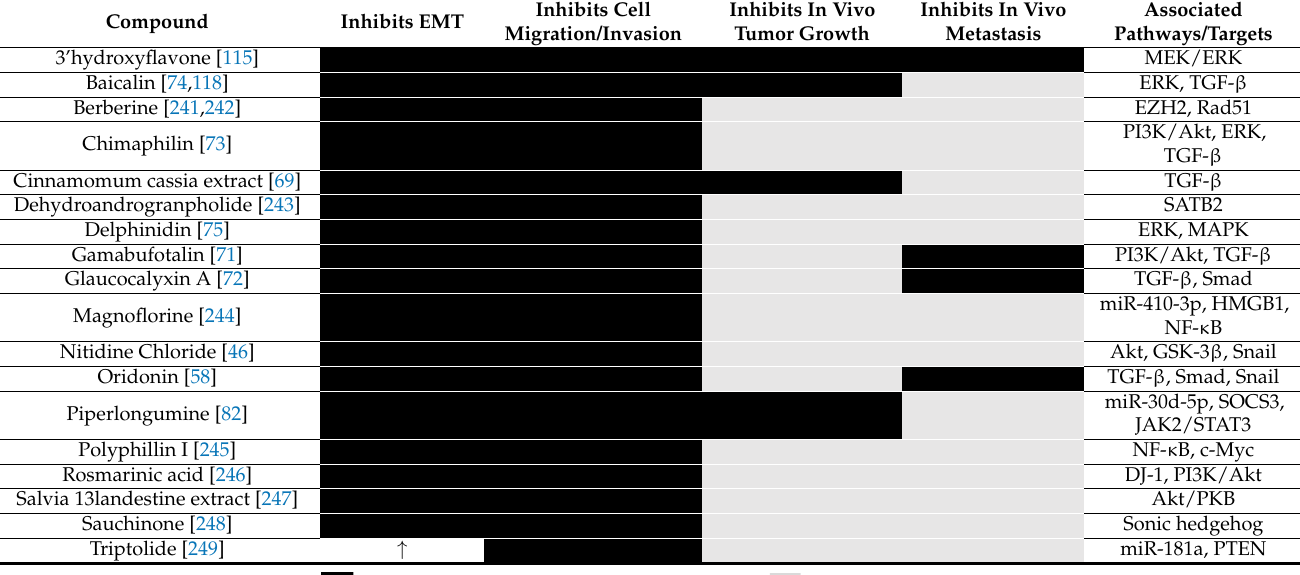
Table 2. Effects of poorly expressed proteins in OS.